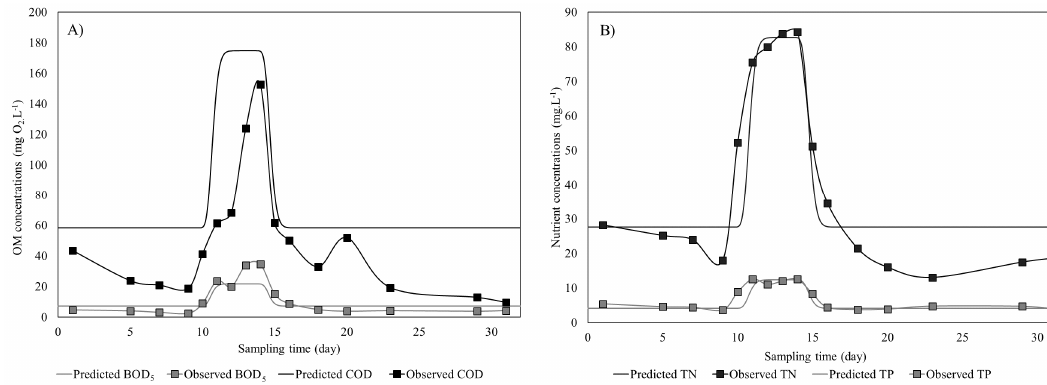
Figure 4. Predicted and observed effluent concentrations of conventional activated sludge (AS) systems during the peak scenario (( A ): Organic Matter (OM), ( B ): nutrients).